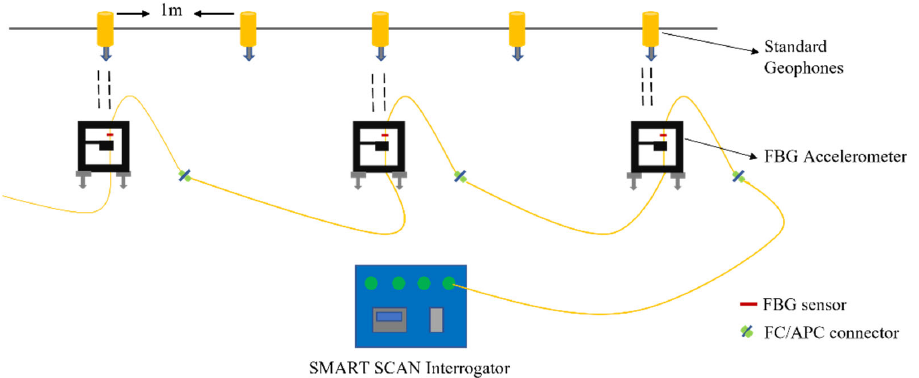
Figure 10. Schematic diagram of the field test.